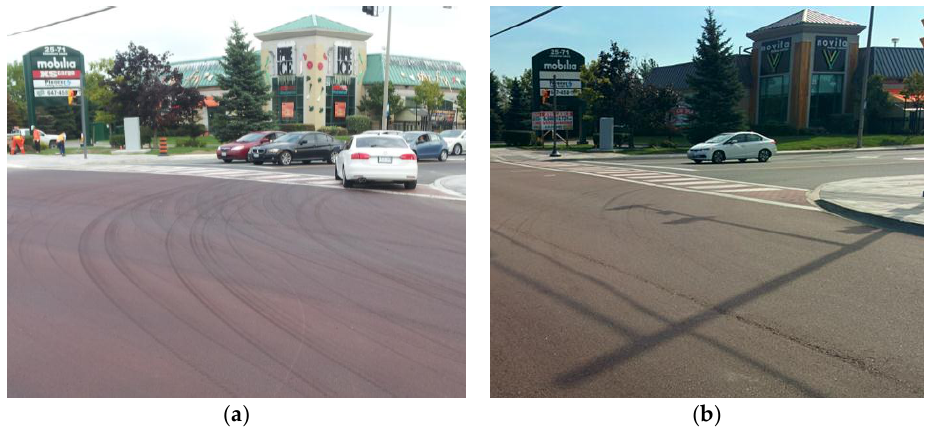
Figure 7. Tire marks at red asphalt sections paved by the Initial Red mixture: ( a ) newly paved section; ( b ) two-year-old section.